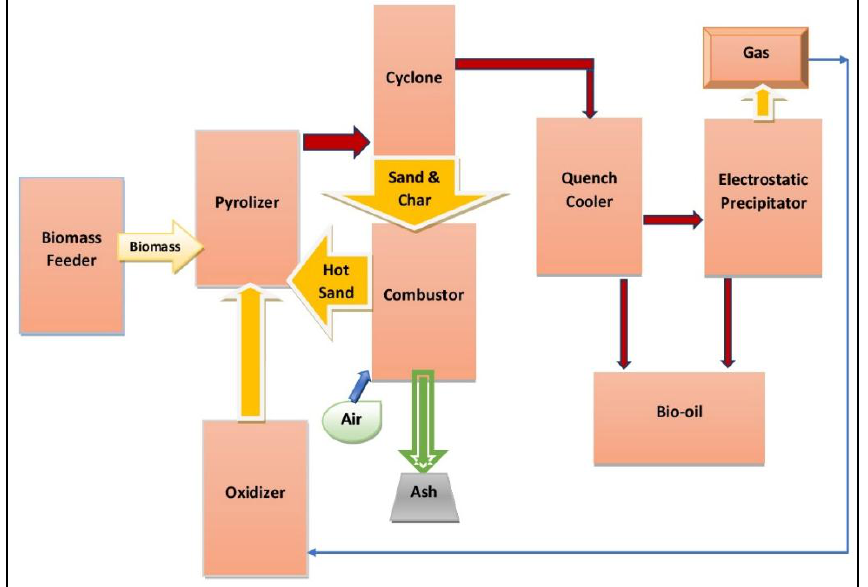
Figure 7. Circulating fluid bed reactor.